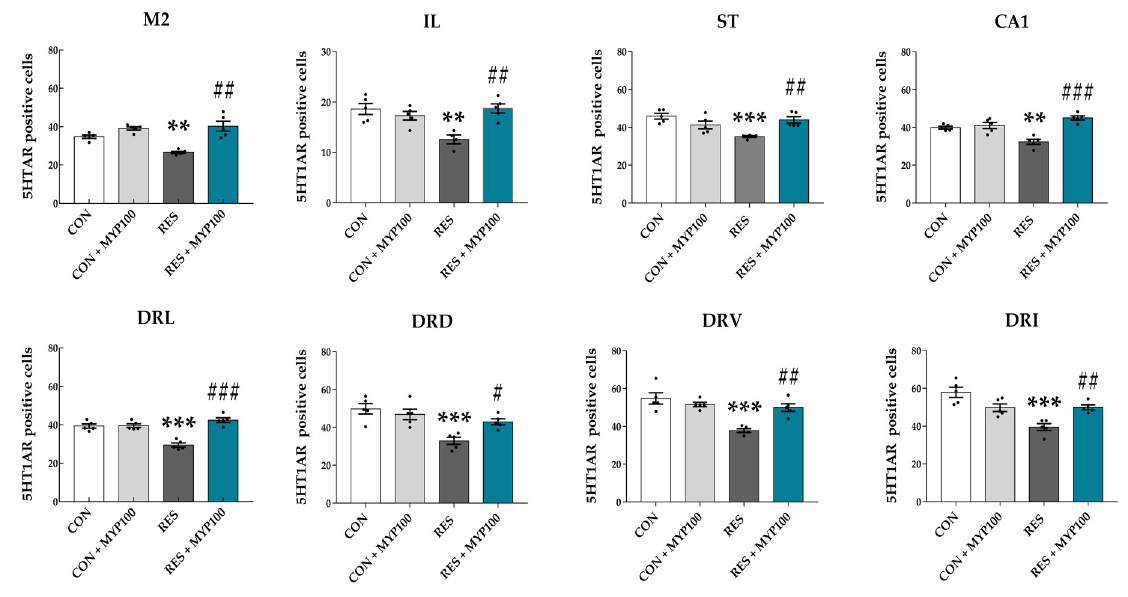
Figure 6. Changes in 5-HT1A receptor (5-HT1AR) expression in each brain region following myelophil (MYP) treatment. The number of 5-HT1AR-positive cells was significantly changed by 100 mg/kg MYP treatment in the motor cortex area 2 (M2), infralimbic cortex (IL), striatum (ST), cornu ammonis area 1 of hippocampus (CA1), lateral part of the dorsal raphe nucleus (DRL), dorsal part of the dorsal raphe nucleus (DRD), ventral part of the dorsal raphe nucleus (DRV), and interfascicular part of the dorsal raphe nucleus (DRI) regions. CON: control ( n = 5), CON + MYP100: 100 mg/kg MYP treatment ( n = 5), RES: 2 mg/kg of reserpine treatment ( n = 5), RES + MYP100: 2 mg/kg of reserpine followed by 100 mg/kg of MYP treatment ( n = 5). Data are expressed as means ± SEM. One-way ANOVA test with Tukey post hoc tests was executed. ** p < 0.01, *** p < 0.001, vs. CON; # p < 0.05, ## p < 0.01, ### p < 0.001 vs. RES.